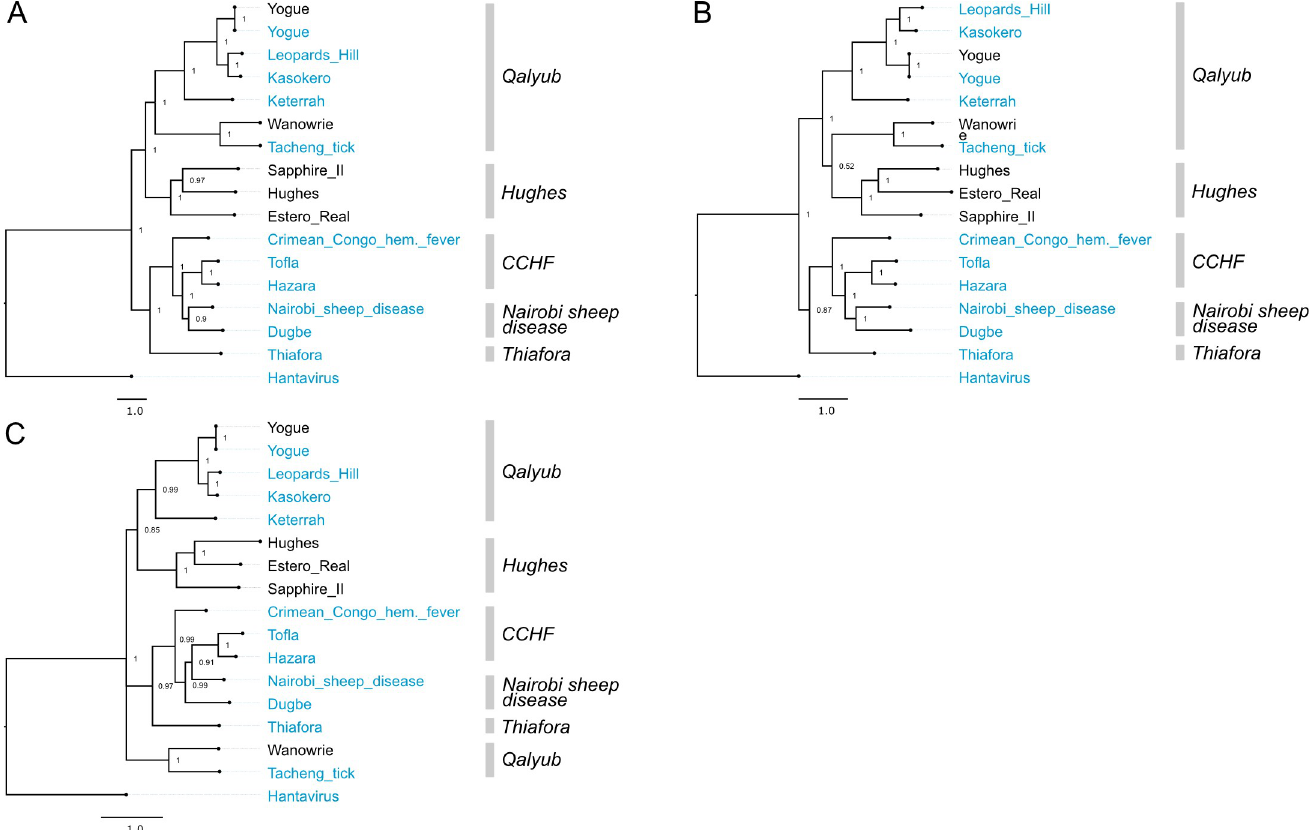
Fig 5. Phylogenetic analysis of viruses in Nairoviridae . Bayesian phylogenetic tree using (A) the ORF encoding the RdRp on the L segment, (B) the ORF encoding Gn/NSm/Gc on the M segment, and (C) the ORF encoding NP on the S segment. Numbers at nodes indicate posterior probability values. Reference sequences are included as phylogenetic landmarks and colored blue. Sequences generated in this study are colored black. Classical serogroup distinctions are indicated. Scale bars represent substitutions per site.